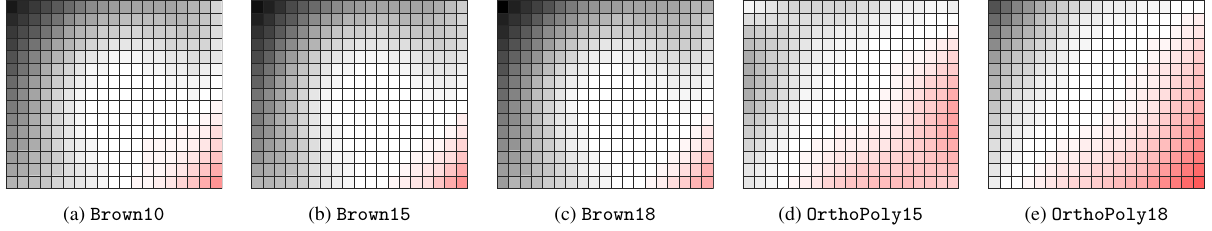
Figure 4. Radial component of (cid:126)v M as a function of image coordinates. Black corresponds to +10 pixels and red to − 10 pixels.